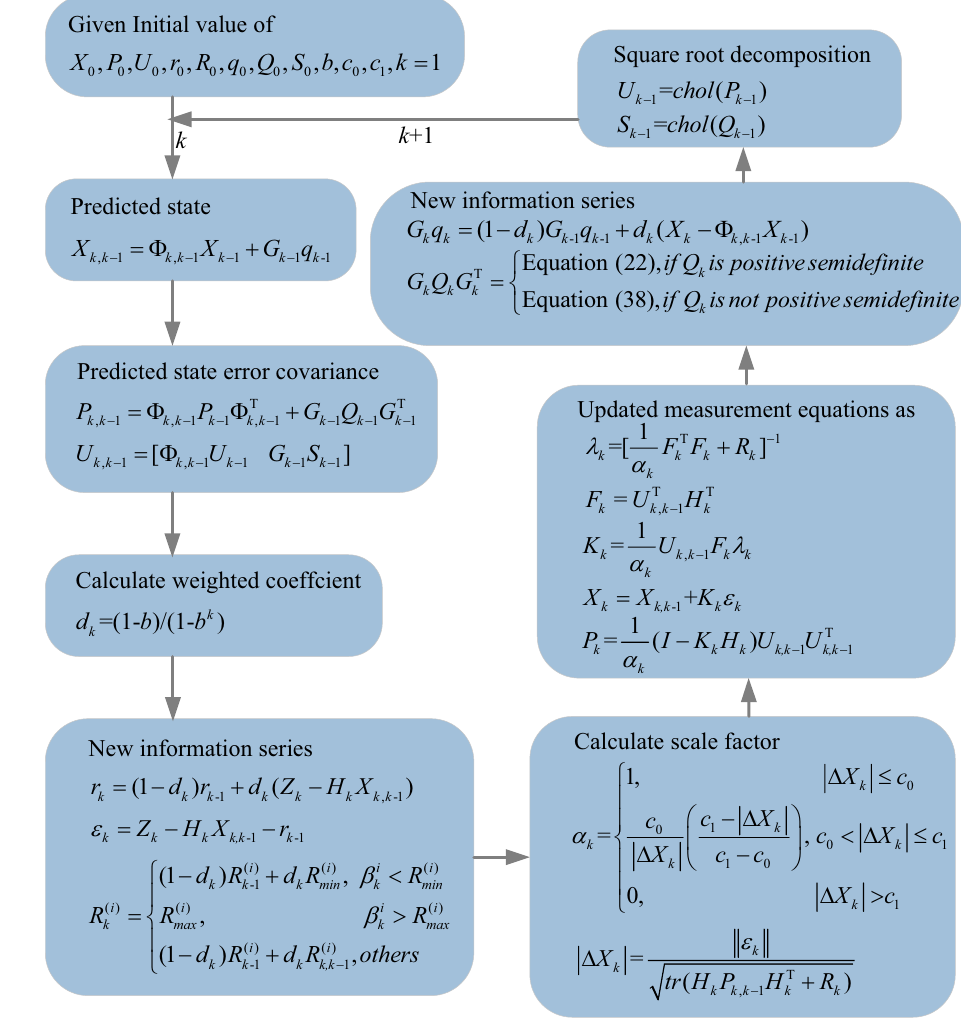
Figure 2. Flow chart of the SR-SHARKF